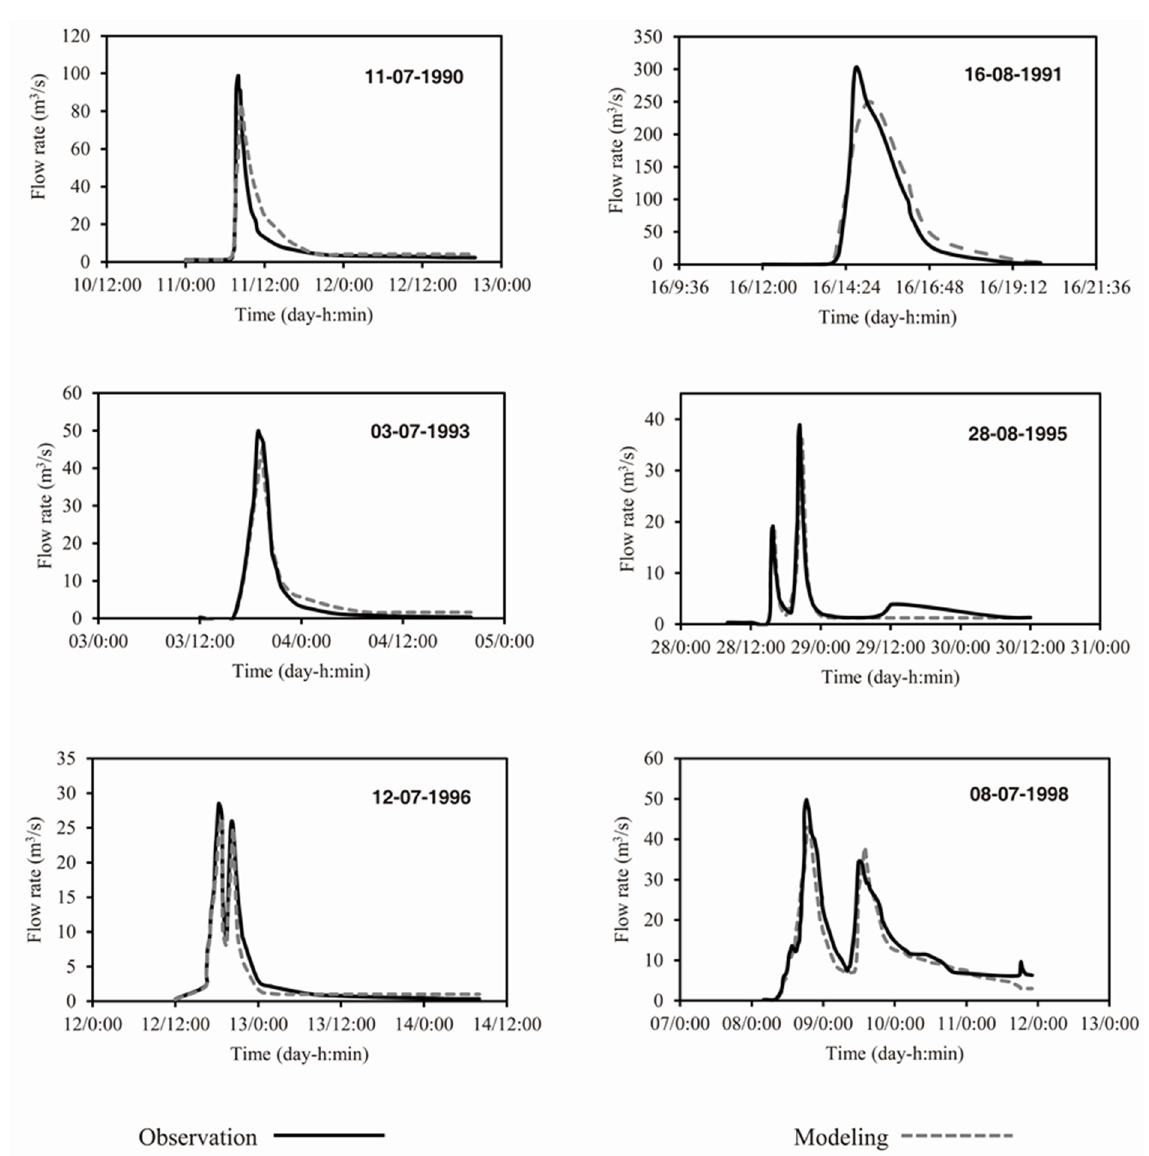
Figure 4. Flow Rate vs Time, Scheme І